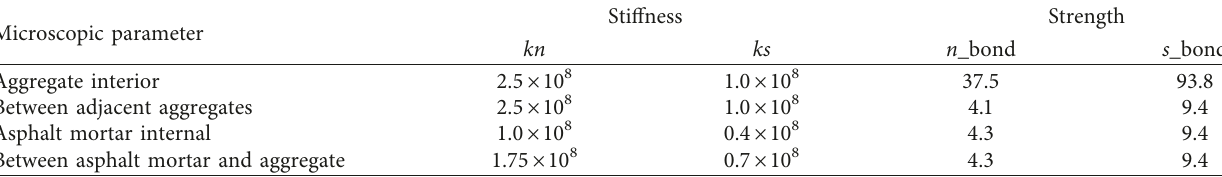
Table 6: Microscopic parameters of mixtures of AC-13.